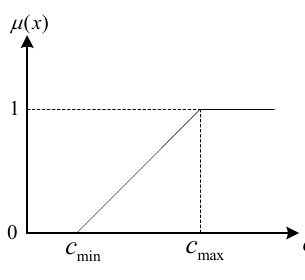
Figure 4. Membership function of the